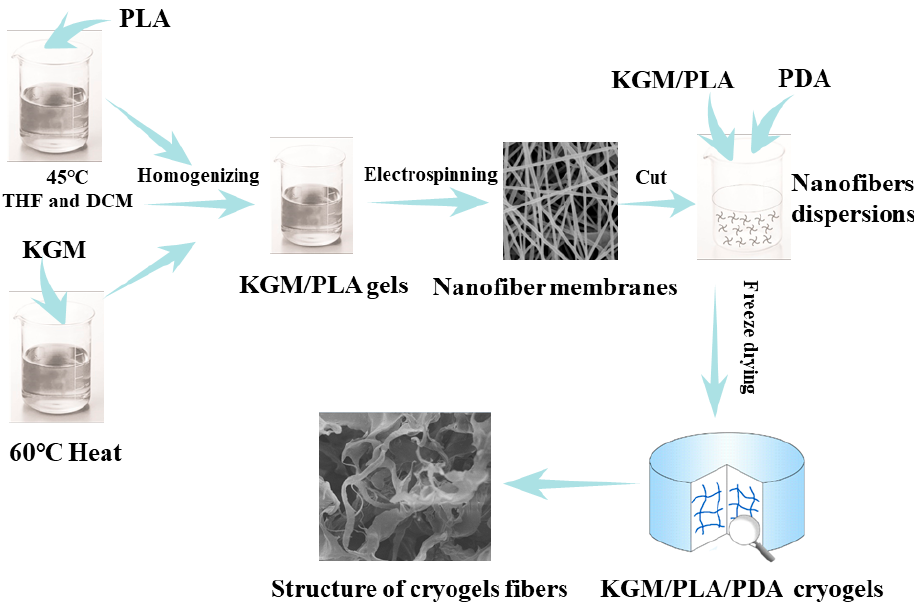
Figure 10. Synthesis scheme of biodegradable nanofiber-assembled NFCs based on konjac glucomannan (KGM)/polydopamine (PDA)/poly (lactic acid).